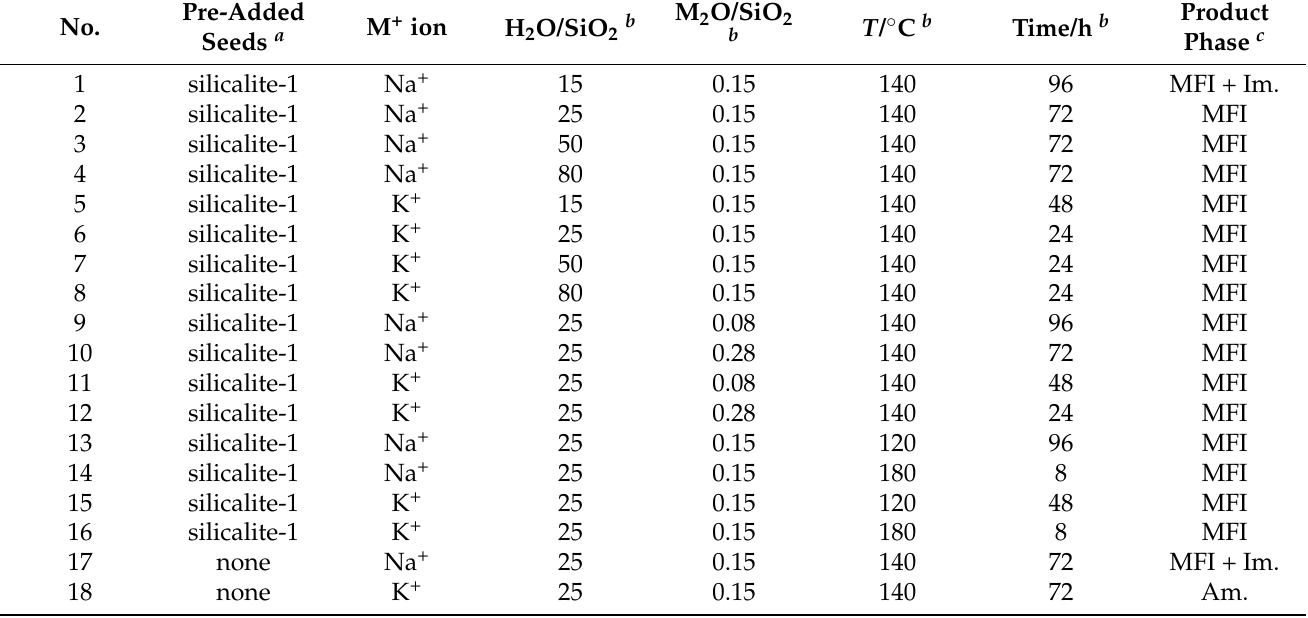
Table 1. Initial synthesis compositions or conditions and corresponding product phase in ions- mediated seed-assisted